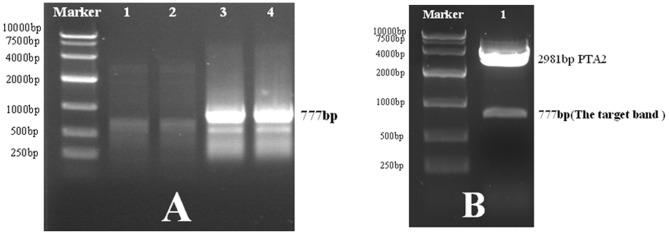
Establishing the LBP mutant phase library.A. The first and second lanes are the PCR products obtained after annealing at 59°C. The third and fourth lanes are the PCR products obtained after annealing at 57°C and these were collected. B. Restriction enzyme digestion after ligation of the PCR products with PTA2. The target band appeared in the 777-bp fragment (lane 1).